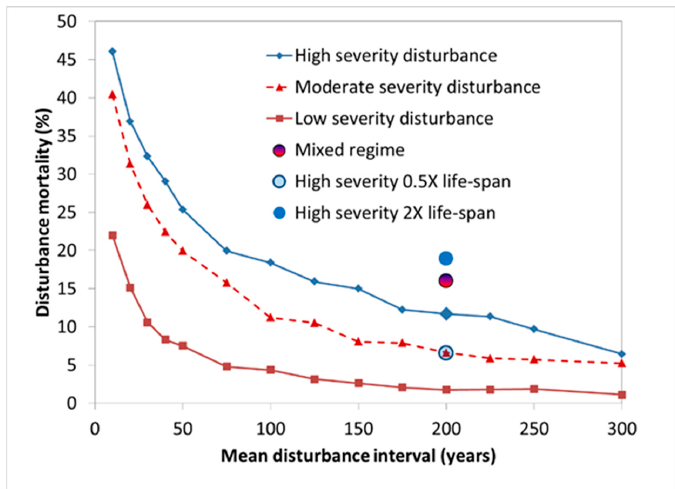
Figure 2. The fraction of total mortality contributed by disturbances as a function of the mean disturbance interval and the severity of mortality. The low and high severity regimes are as for Figure 1; moderate severity disturbance had a mortality rate of 37.5%–62.5%. Each data point was the average of 25–35 simulations. The mixed regime is the one used in Figure 1. For those data points indicating 0.5× and 2× lifespans, the maximum lifespan of branches, coarse roots, and stems was either halved or doubled, respectively.